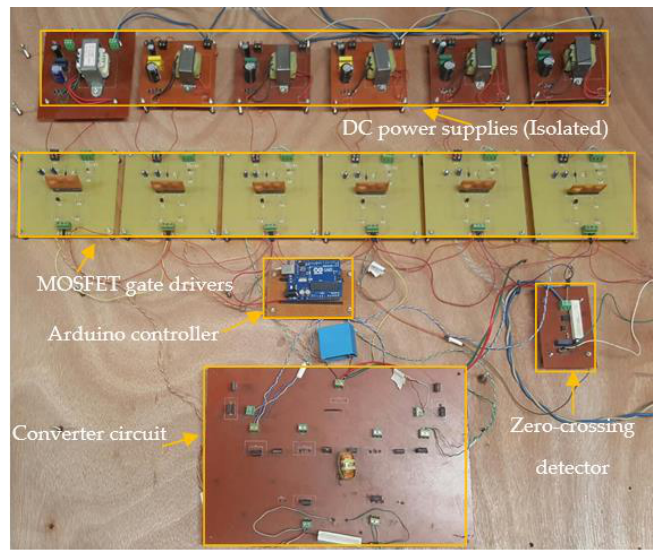
Figure 15. The practical architecture of the proposed converter.